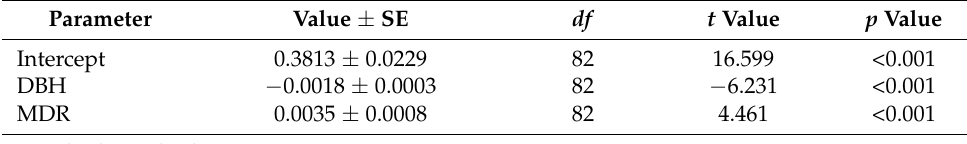
Table 10. Parameter estimates of the best candidate model 3, Table 9.